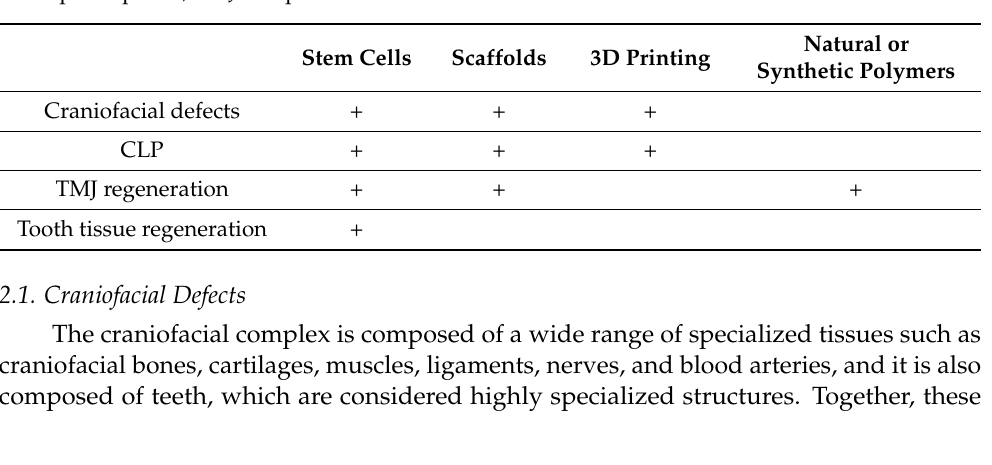
Table 1. Biotechnological applications used for regeneration in the cranio-dento-facial complex. CLP: cleft lip and palate; TMJ: temporomandibular disorder.